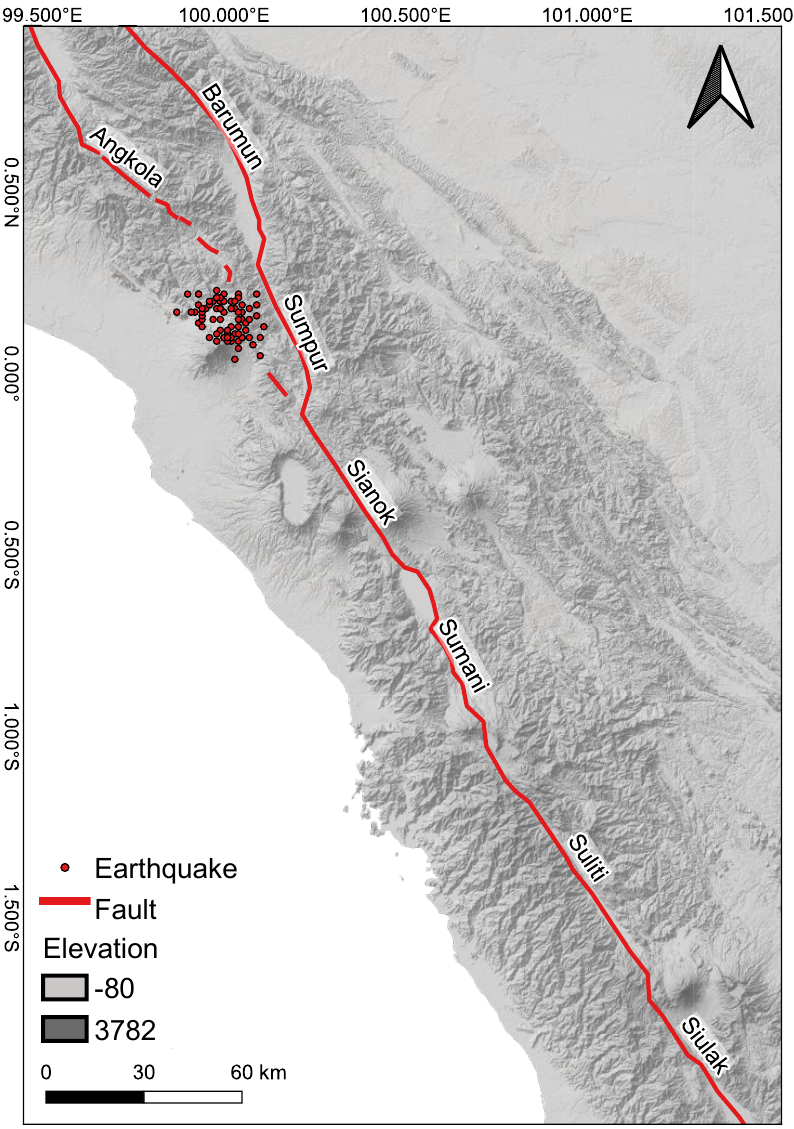
Figure 4. Central Sumatra Fault Zone. The 2022 Pasaman earthquake took place in an area where the existence of the fault is still uncertain.